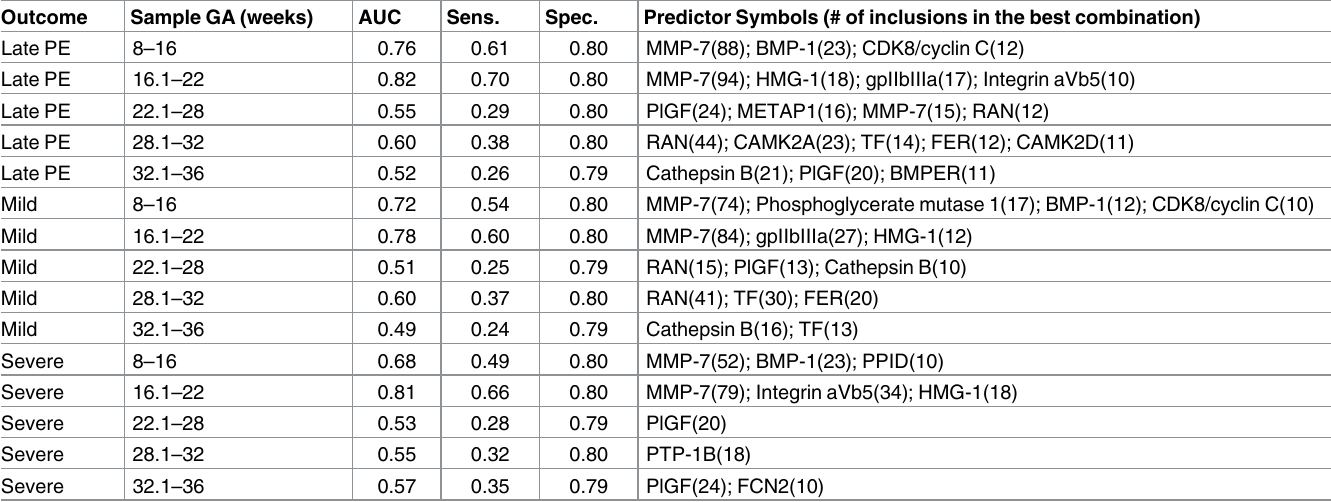
Table 3. Summaryof prediction performancefor late-onset preeclampsia evaluated by bootstrap.